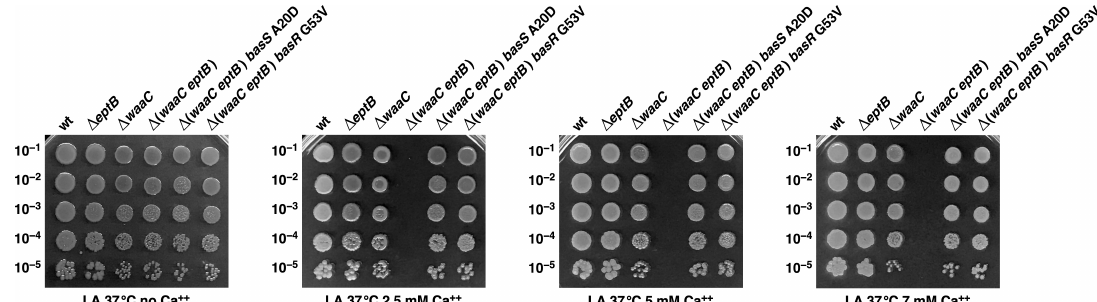
Figure 7. Suppression of the Ca ++ sensitivity of ∆ ( waaC eptB ) by mutations in either the basS or the basR genes. Exponentially grown cultures of the wild type and its isogenic deletion derivatives of waaC , eptB , ∆ ( waaC eptB ), and strains with the suppressor mutation in either the basS or the basR genes were adjusted to an OD 595 of 0.1 and serially spot diluted at 37 ◦ C in LA agar, either supplemented with varying concentrations of CaCl 2 , or without supplementation with CaCl 2 , as indicated. Plates were incubated for 24 h and the data presented are from one of the representative